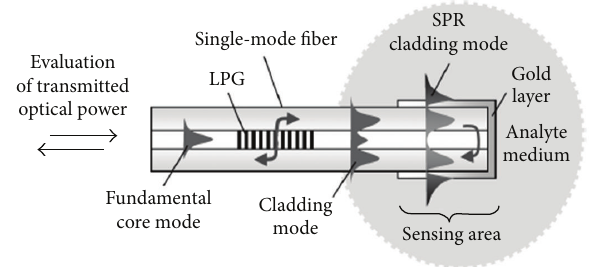
Figure 17: Refractometric sensor in a reflection configuration based on a LPFG-assisted SPR (taken from [82]).